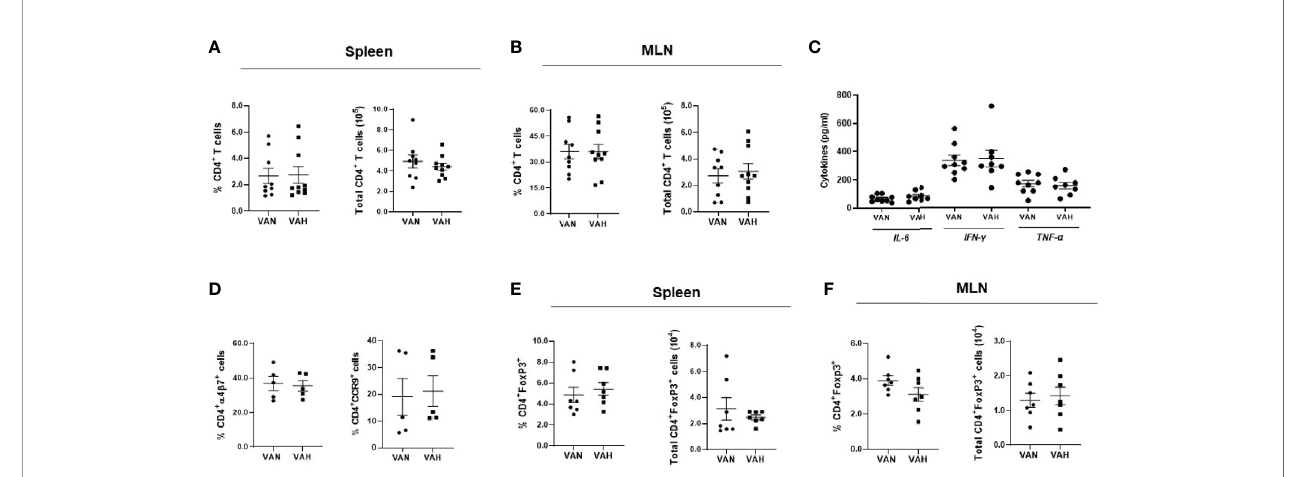
FIGURE 3 | Dietary vitamin A supplementation does not affect donor T-cell compartment after allogeneic BMT. Lethally irradiated VAN and VAH mice were transplanted with BM (6 – 10 x 10 6 ) plus 0.3 – 0.4 x 10 6 puri fi ed T cells from B6 mice. On Day 7 post-BMT, the percentage and absolute number of donor H ‐ 2 b+ CD4 + T cells in the spleen (A) and MLNs (B) were examined. (C) Serum proin fl ammatory cytokine levels were determined by cytometric bead array. Data are shown as Mean ± SEM and are cumulative results from three independent experiments. (D) The percentage of donor H ‐ 2 b+ CD4 + T cells expressing a 4 b 7 and CCR9 from MLNs of recipient mice was examined. Data are shown as Mean ± SEM and are cumulative results from two experiments. (E, F) BMT was performed as described above except Foxp3 + EGFP + mice were used as donors. On Day 7 post-BMT, the percentage and absolute number of donor H ‐ 2 b+ CD4 + Foxp3 + Tregs in the spleen (E) and MLNs (F) were examined (n = 7 per group). Data are shown as Mean ± SEM and are cumulative results from two independent